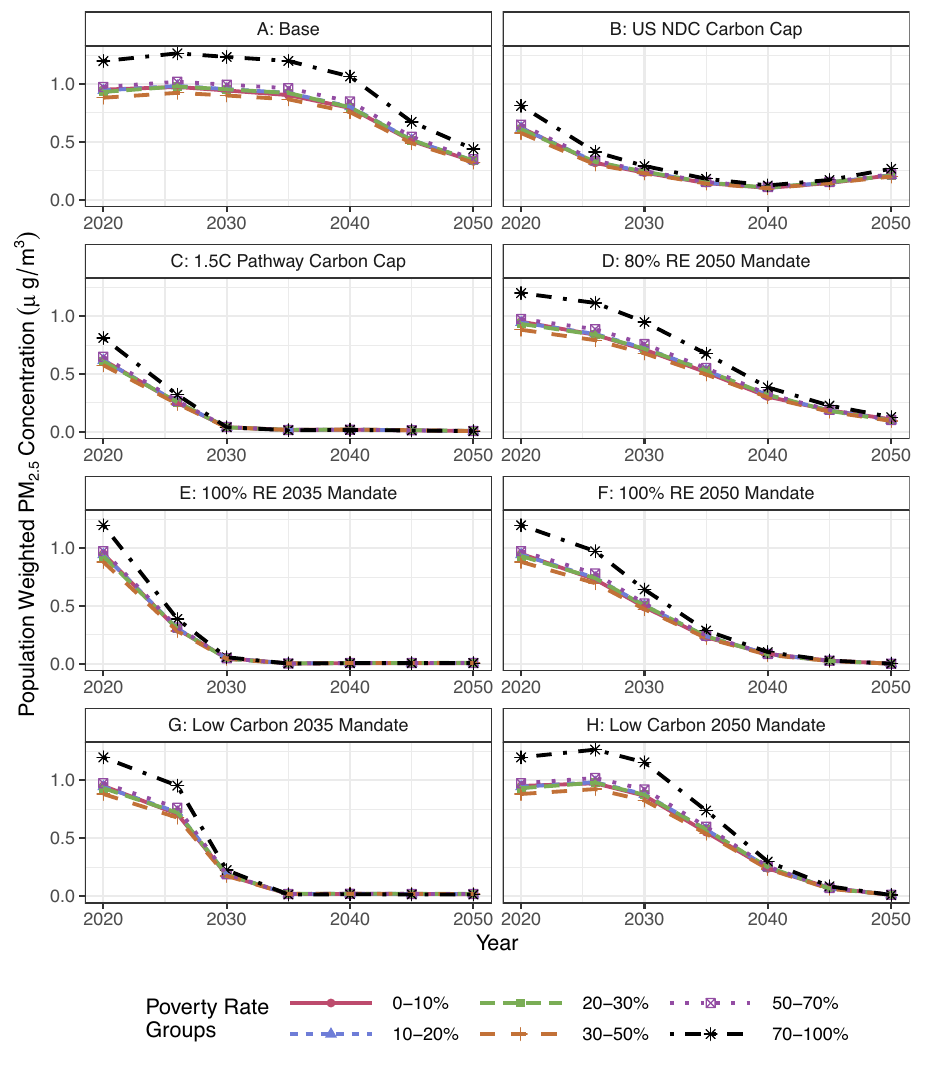
Fig. 5 | Population weighted average annual PM 2.5 concentration across pov- ertyrateswithincensustractsforeachscenario2020 – 2050. Weseethatcensus tracts with poverty rates >70% are burdened with the highest concentrations